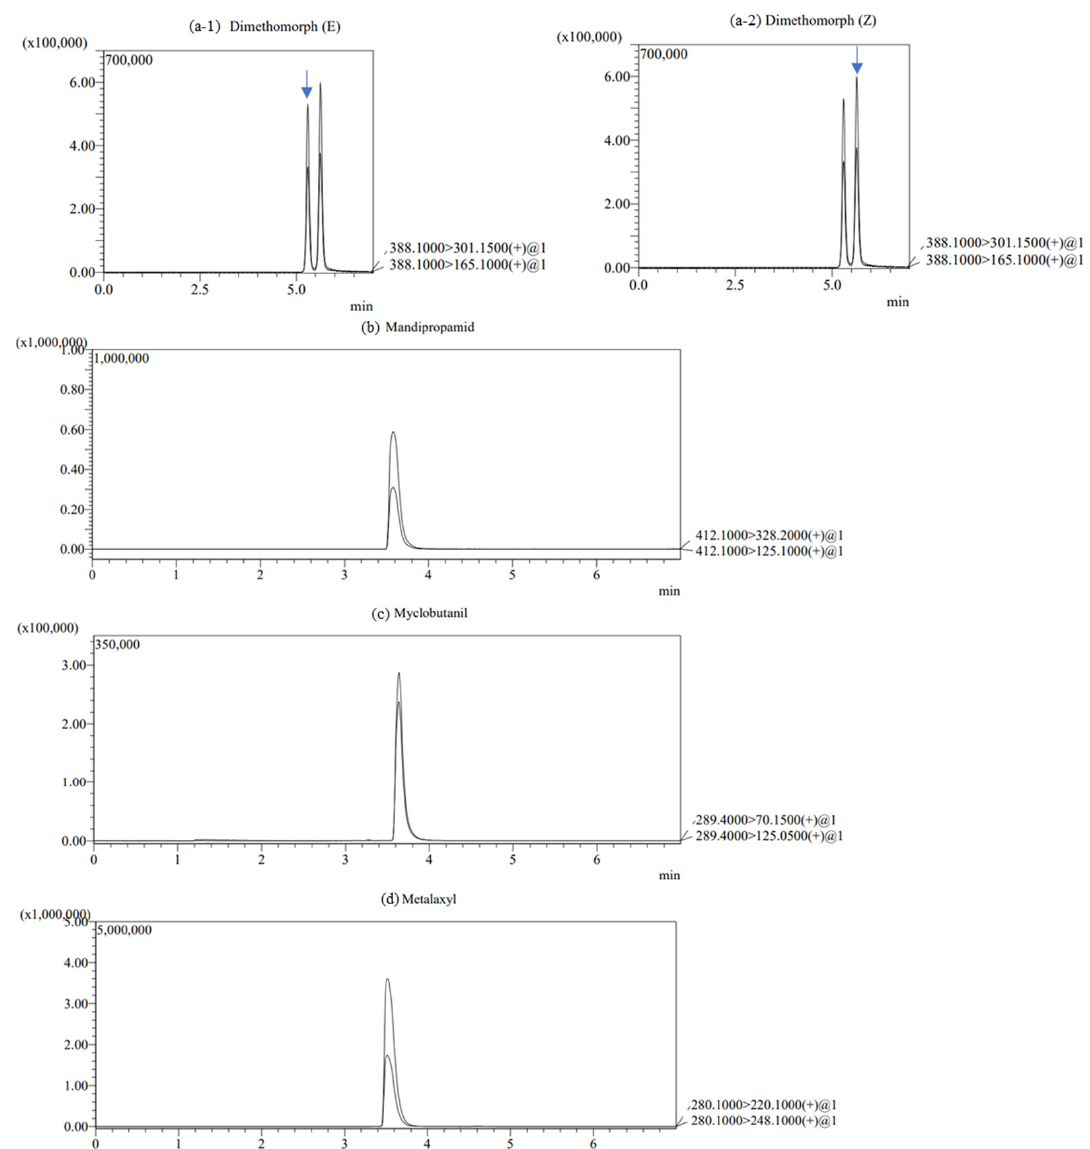
Figure 1. Representative chromatogram (0.1 mg/kg) of ( a-1 ) dimethomorph (E), ( a-2 ) dimethomorph (Z), ( b ) mandipropamid, ( c ) myclobutanil, ( d ) metalaxyl.